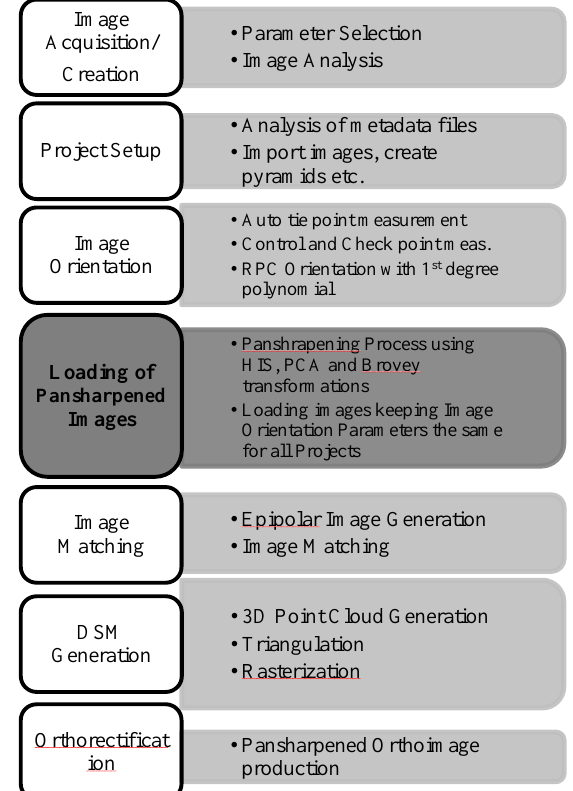
Figure 2: Workflow chart for checking the effects of pansharpening